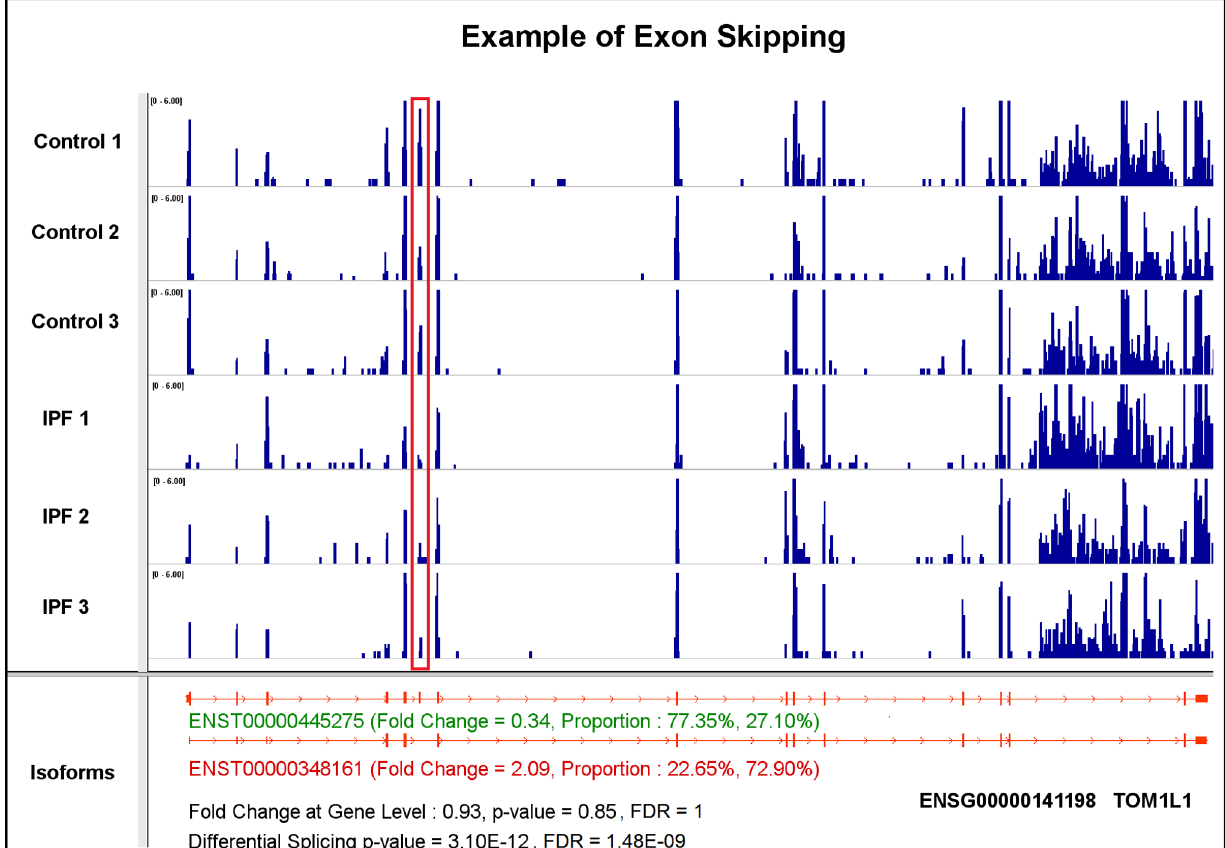
Figure 2. A case study of gene TOM1L1 illustrating the skipping exon splicing mechanism using the annotated transcripts.